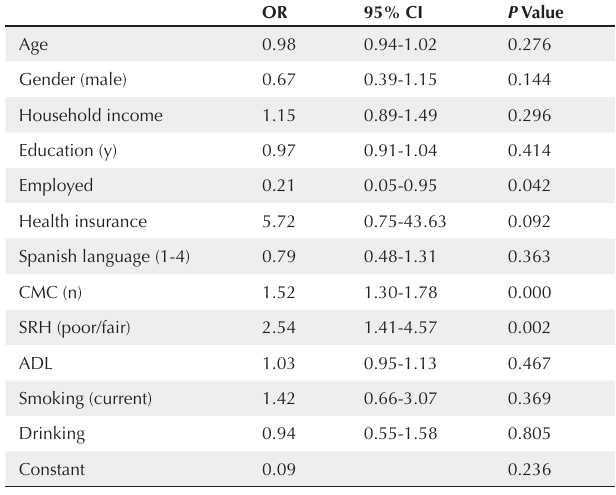
Table 1. Descriptive Characteristics of Participants Table 2. Logistic Regression on Polypharmacy in Older Foreign-Born Mexican American Adults